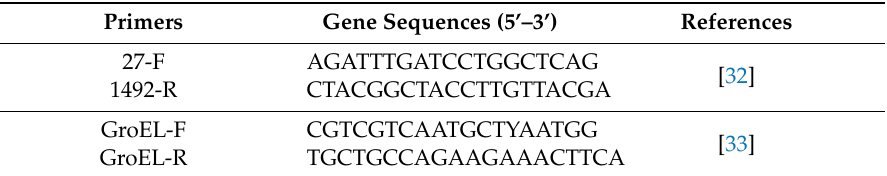
Table 6. Primers sequences of PCR